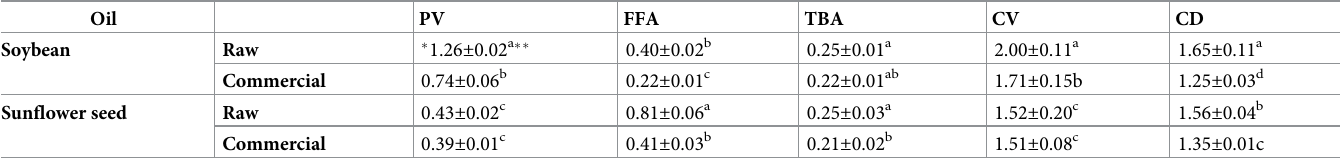
Table 1. Oxidative stability parameters of raw and commercial soybean and sunflower oils.